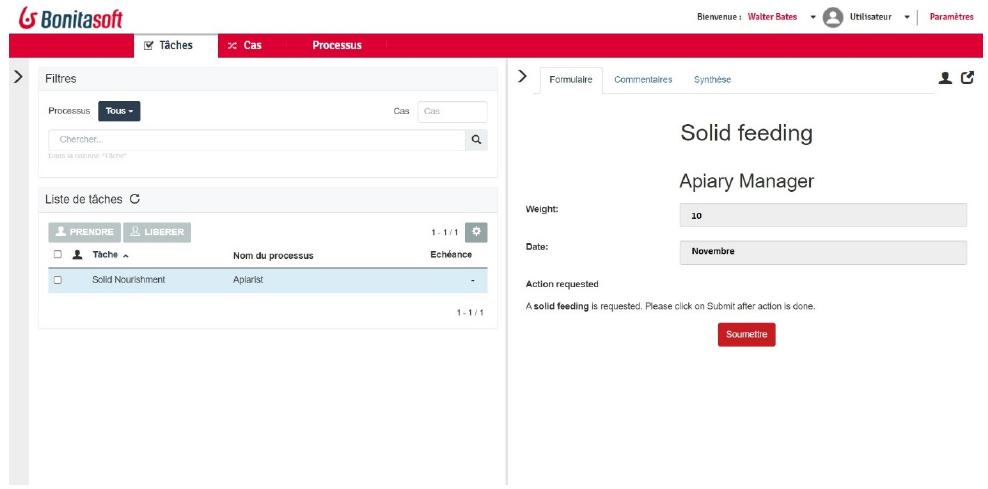
Figure 12. Simulation using Bonita software.